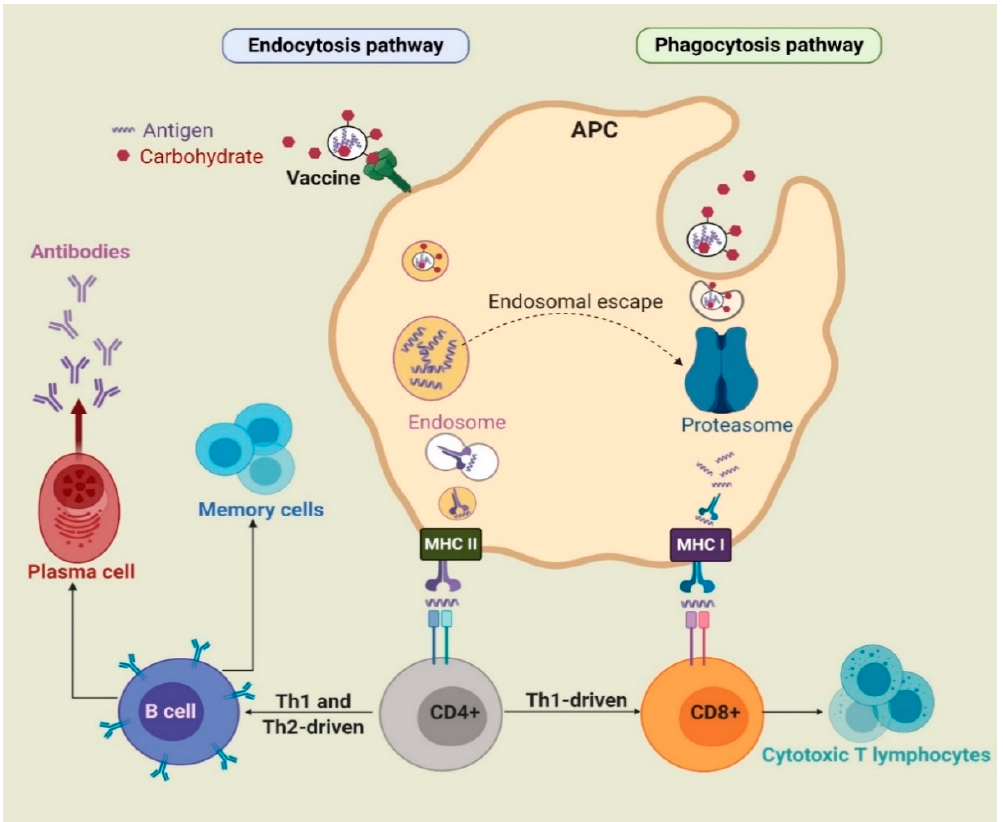
Figure 1. The basic uptake pathways of antigens (e.g., endocytosis and phagocytosis) by antigen- The basic uptake pathways of antigens (e.g., endocytosis and phagocytosis) by presenting cells (APCs) to induce immune responses. antigen-presenting cells (APCs) to induce immune